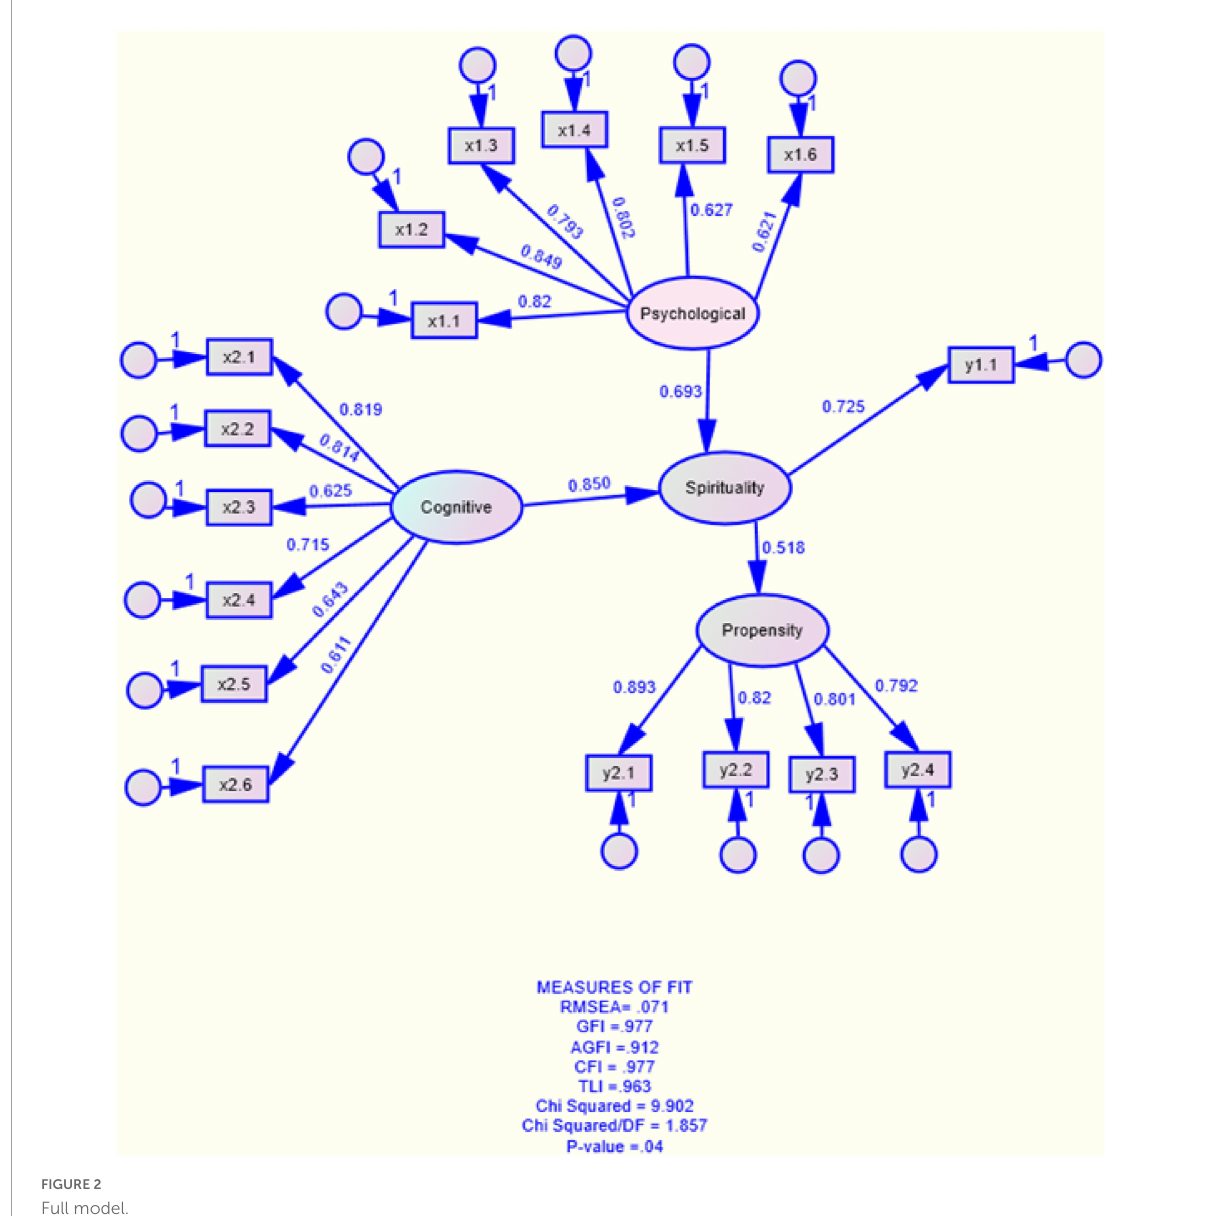
FIGURE2 Full model.